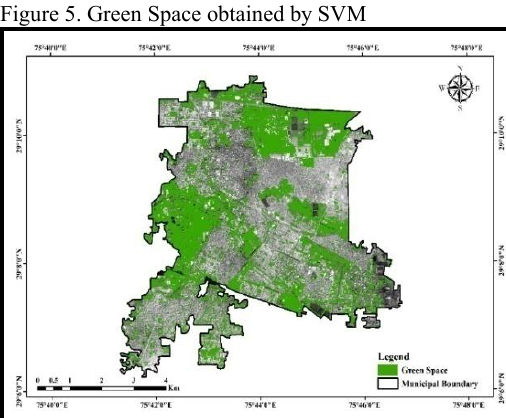
Figure 5. Green Space obtained by SVM